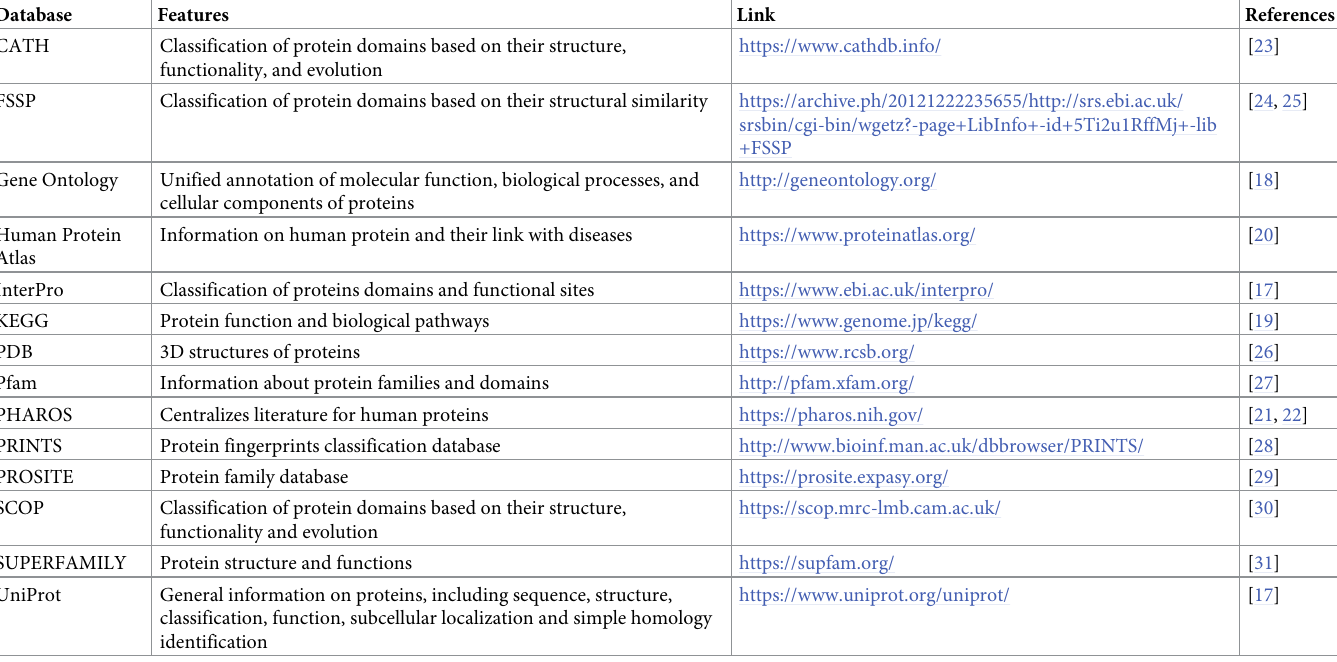
Table 2. List of protein